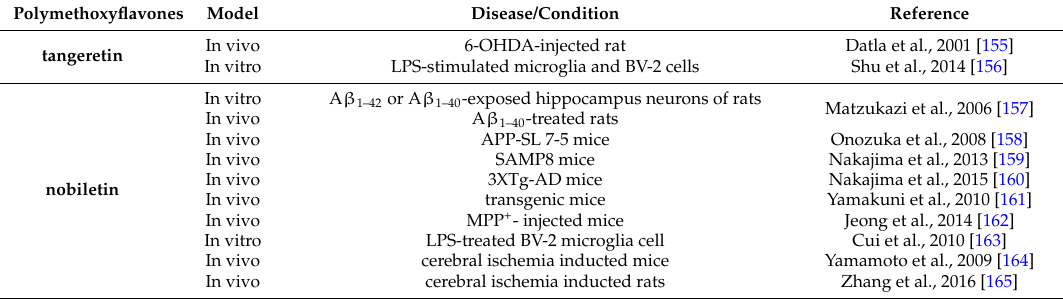
Table 5. Studies and experimental models of neurodegenerative diseases in which tangeretin or nobiletin were